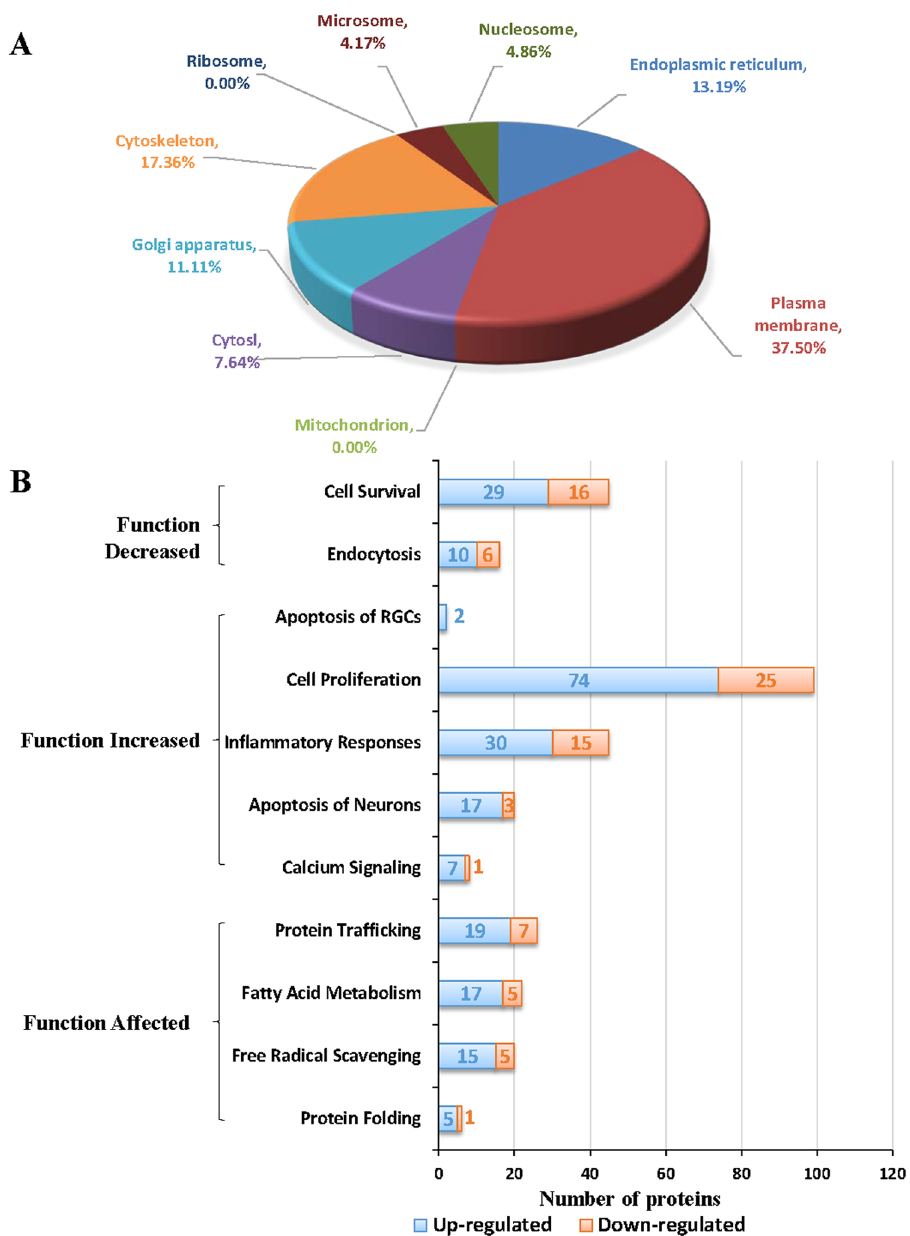
Figure 4. Functional annotation of the MAM proteins that are differentially expressed in db/db mice vs. db/ + controls. ( A ) The major locations of the MAM proteins that are altered in diabetes. ( B ) Bar graph showing the major categories reflecting the key biological processes pertaining to the pathophysiology of diabetic